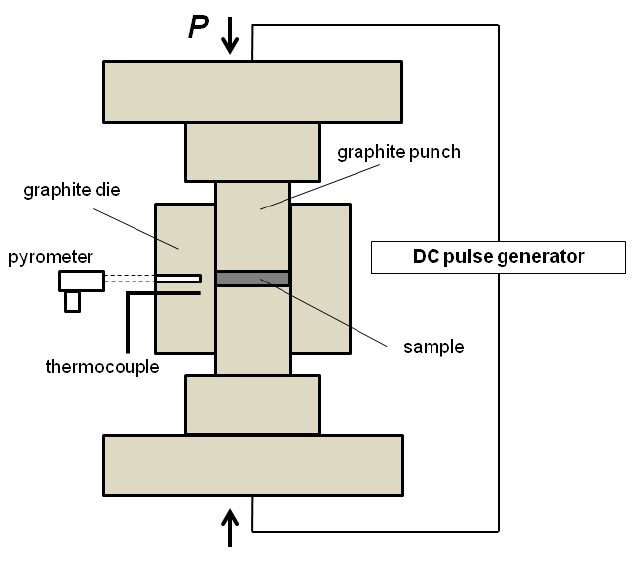
Figure 1. Traditional spark plasma sintering (SPS) tooling geometry (the temperature is measured a pyrometer or a by a pyrometer or a thermocouple).